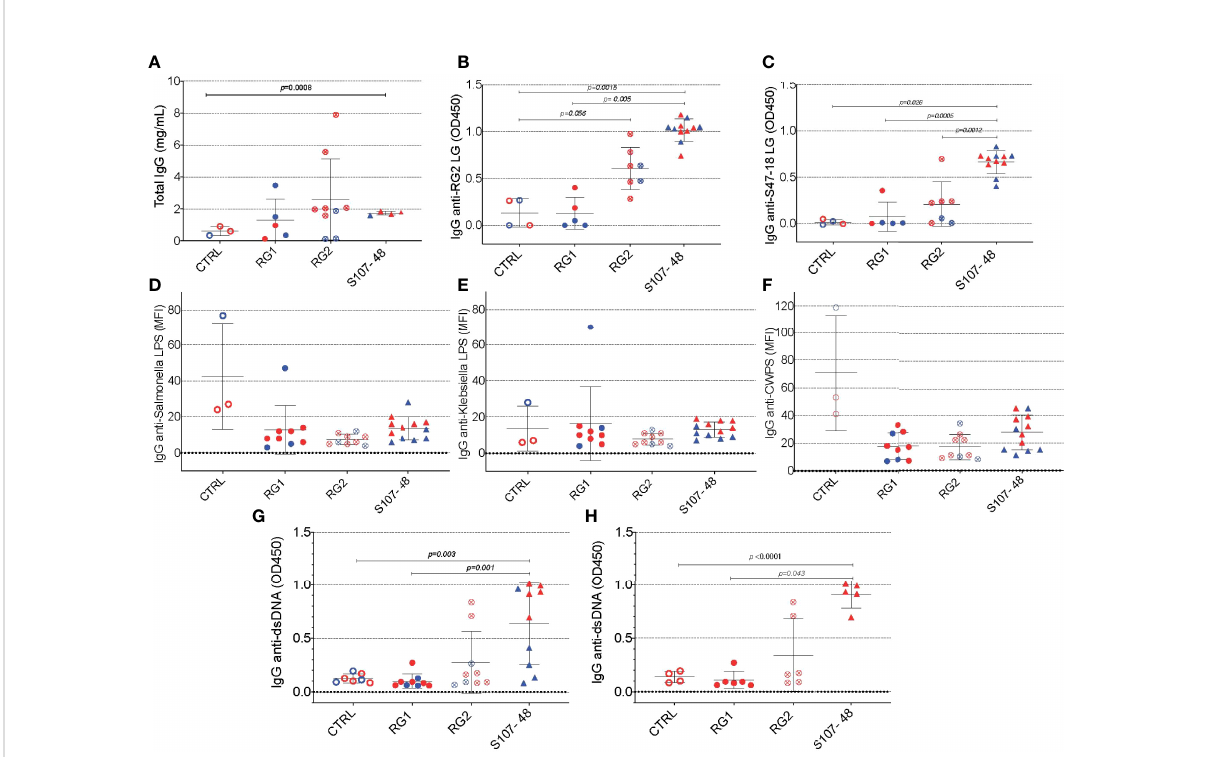
FIGURE 6 Intestinal colonization with certain RG strains induces IgG RG strain-associated cell wall lipoglycan antibodies and anti-native DNA autoantibodies. (A) Following neonatal colonization of litters from RG colonized GF breeding pairs, S107-48 RG strain colonized mice display numerically higher mean serum total IgG levels, compared to controls. (B) Neonatal colonization with the RG2 strain or with the S107-48 RG strain induced signi fi cantly raised serum levels of IgG anti-RG2 strain cell wall lipoglycan antibodies. (C) Neonatal RG colonization does not induce raised IgG-antibody levels to; (D) Salmonella LPS, (E) Klebsiella LPS, or (F) to pneumococcal cell wall polysaccharide (CWPS). (G) Neonatal colonization with the S107-48 RG strain induces raised serum levels of IgG anti-native DNA autoantibodies. (H) Elevation of IgG anti native DNA following neonatal S107-48 RG strain was greatest in the female mice. (n= 4 to 11 per group). Antibody assays for IgG anti- native DNA used plasma diluted at 1:100 in ELISA (OD450). Antibody assays for IgG antibodies to RG lipoglycans, LPS and CWPS